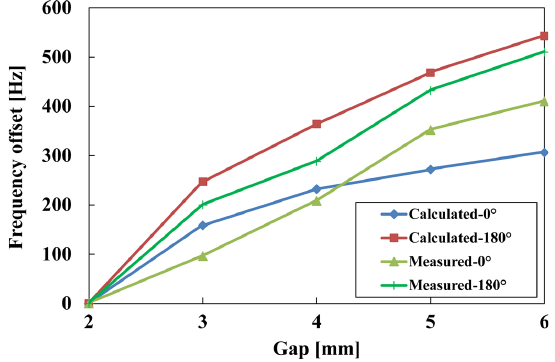
Figure 19. Calculated and measured frequency o ff sets at di ff erent